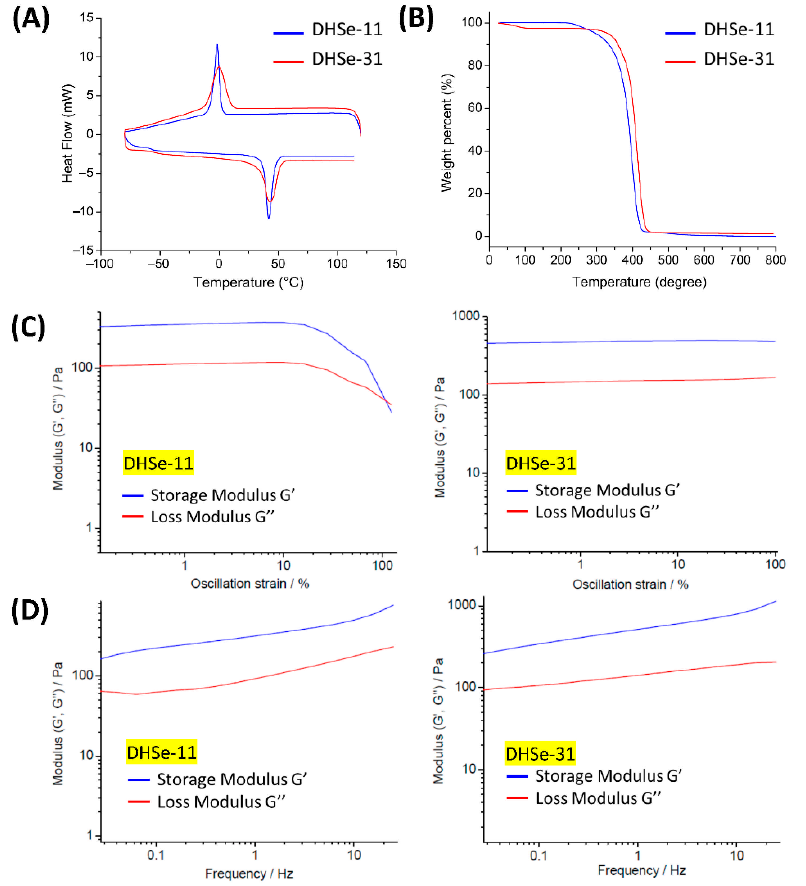
Figure 3. Thermal and rheological properties of hydrogels: ( A , B ) DSC and TGA results; ( C ) oscillatory strain sweep plots; ( D ) frequency sweep of DHSe-11 and DHSe-31 hydrogel.